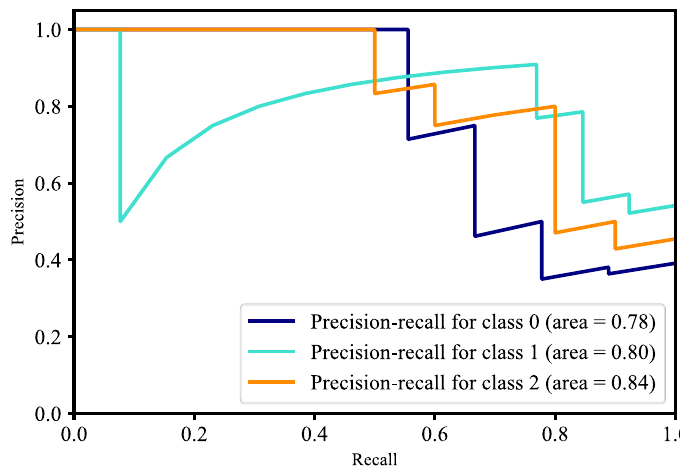
Figure 38. Accuracy of human face detection.